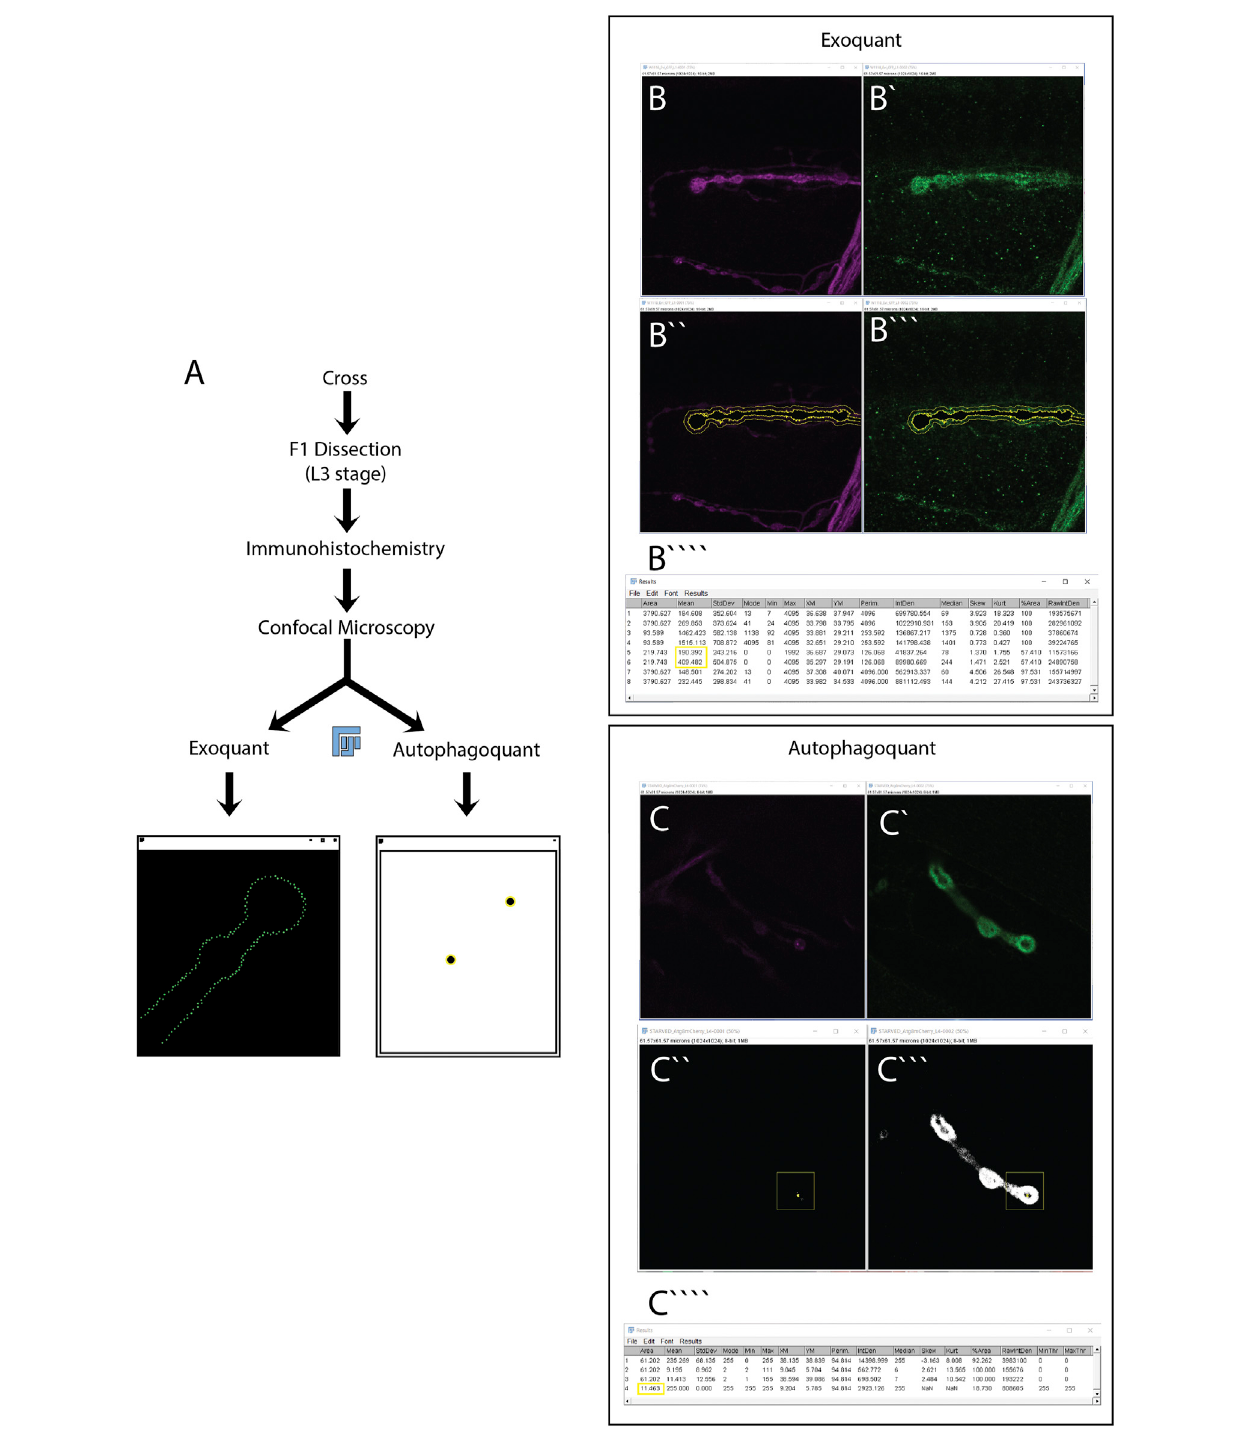
FIGURE 1 | Experimental work fl ow for the quanti fi cation of exosome release and autophagy using the Exoquant and Autophagoquant macros. (A) Parental Drosophila adults (F0) with the correct genotype are cross using a 3:1 female to male ratio at 21 ° C. F1 Drosophila larvae with the desired genotype are dissected in L3 stage. A critical process in the dissection step is to maintain the nerves intact. Dissected larvae are fi xed with PFA before immunohistochemistry using the appropriate antibodies. After the immunohistochemistry, larvae are mounted and imaged using confocal microscopy. Two-channel confocal representative images of Drosophila NMJareselectedforquanti fi cationofexosomerelease (B,B ’ ) orautophagy (C,C ’ ) .Usingthemacros,youwillobtainthesewindowsforExoquant (B ” ,B ”’ ) or Autophagoquant (C ” ,C ”’ ) macros. A fi nal table with the main parametersto quantify exosomerelease (B ”” ) or autophagy (C ”” ) isobtained. The parameters used to do the quanti fi cation in this paper are highlighted in a yellow box.